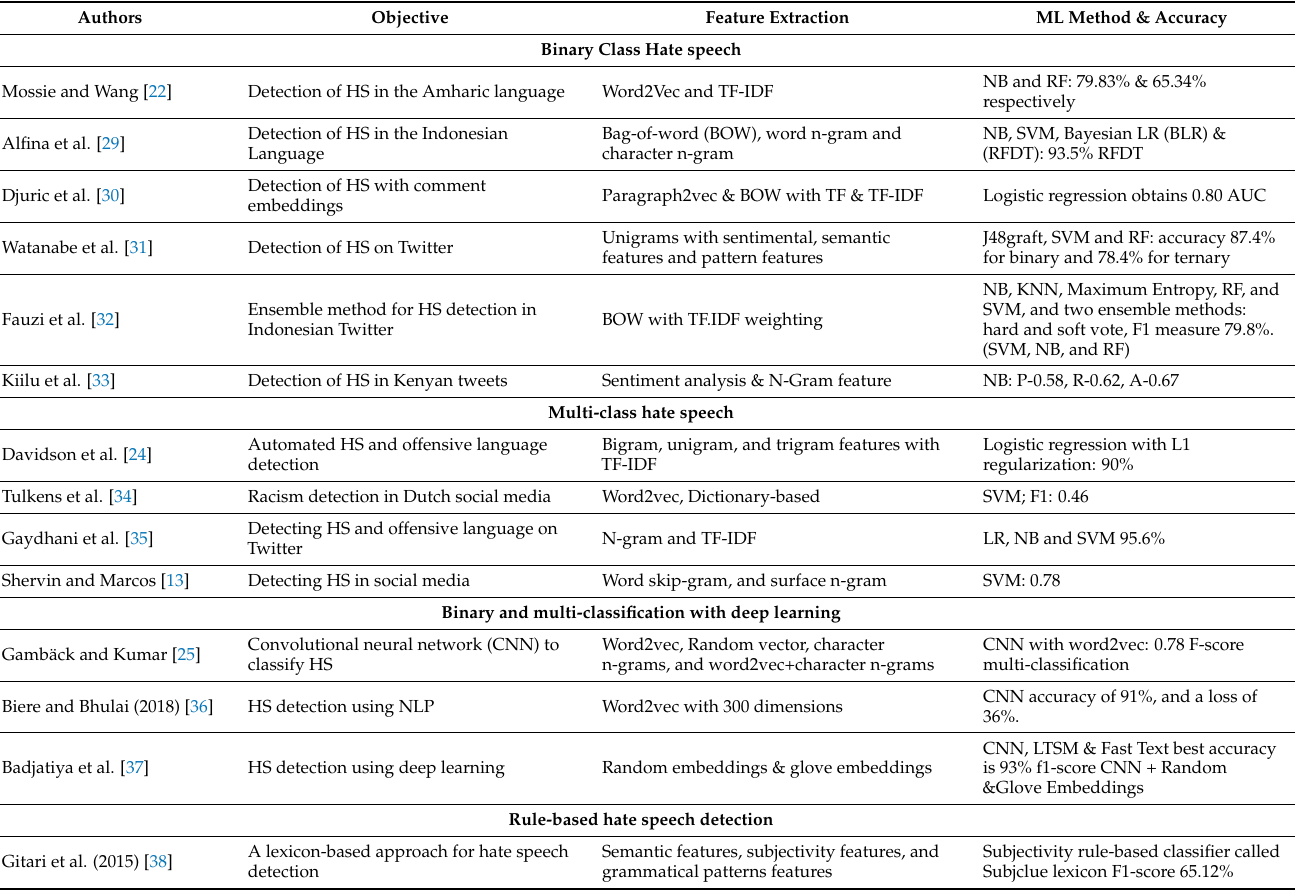
Table 1. Summary of hate speech detection related